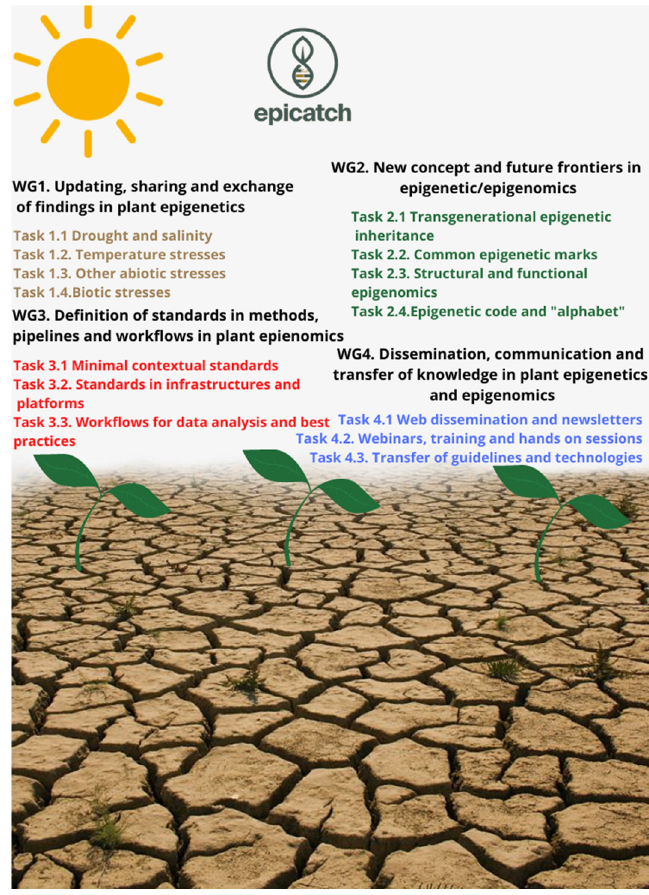
Figure 3. The structure of EPI-CATCH COST Action: working groups and tasks.